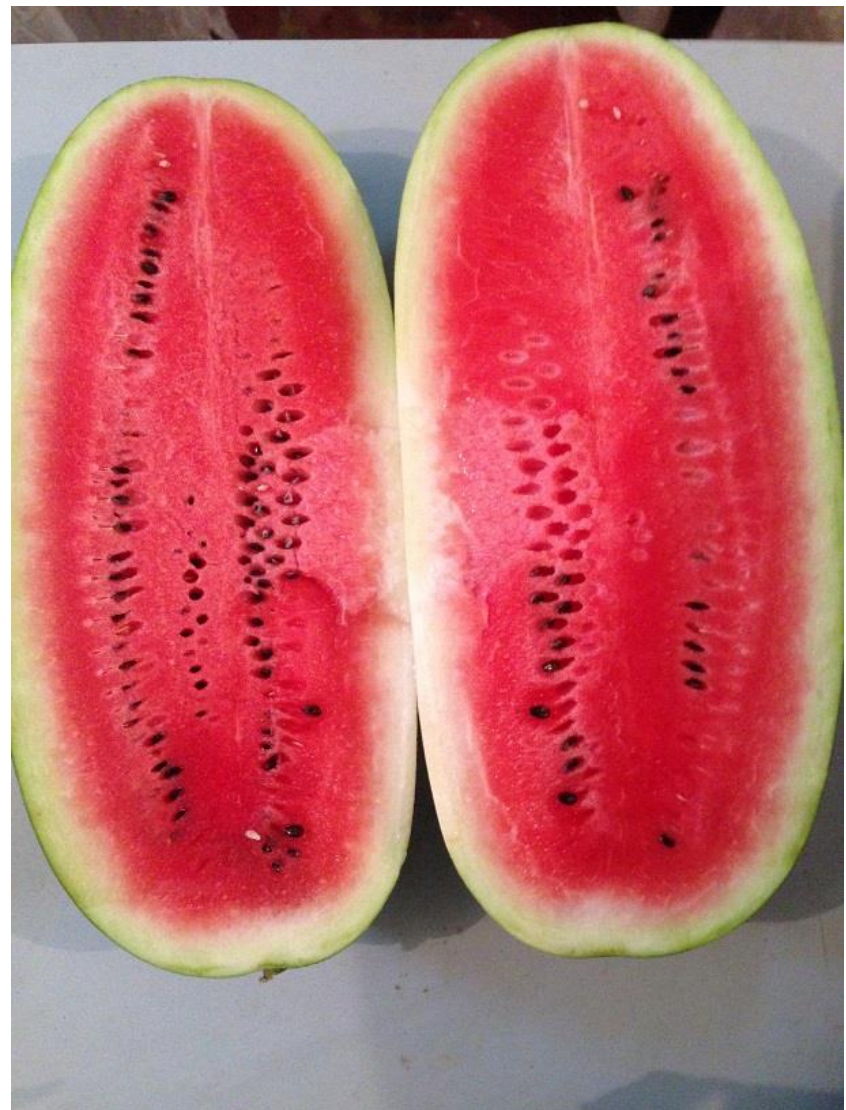
Figure 5. ‘All Sweet’ watermelon variety with attractive red flesh coloration and lack of seeds in